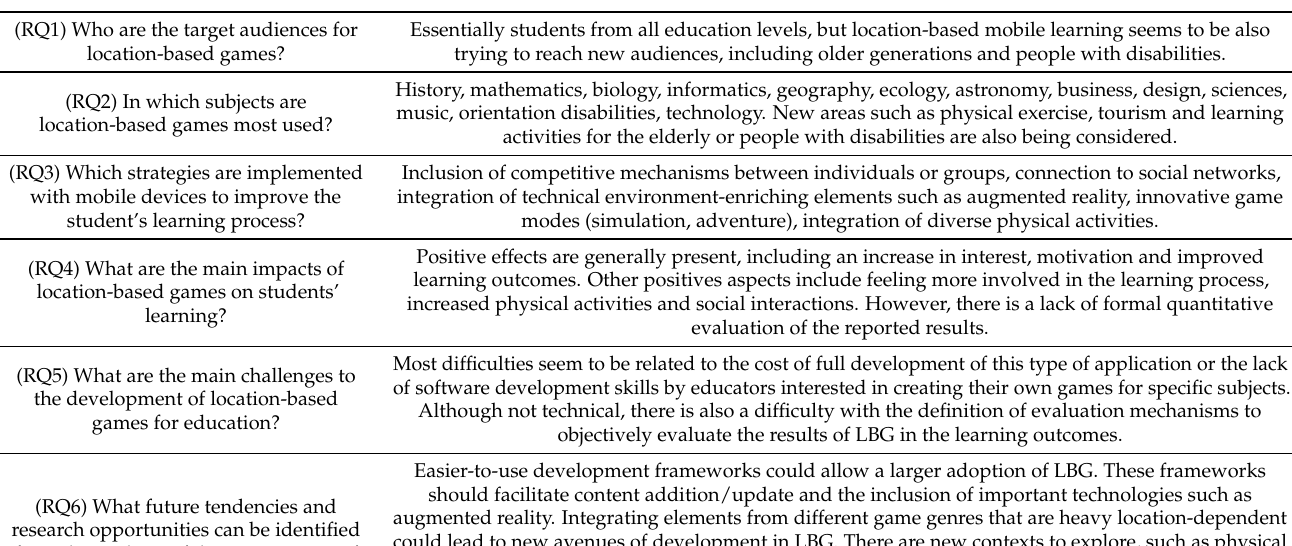
Table 6. Answers to the research